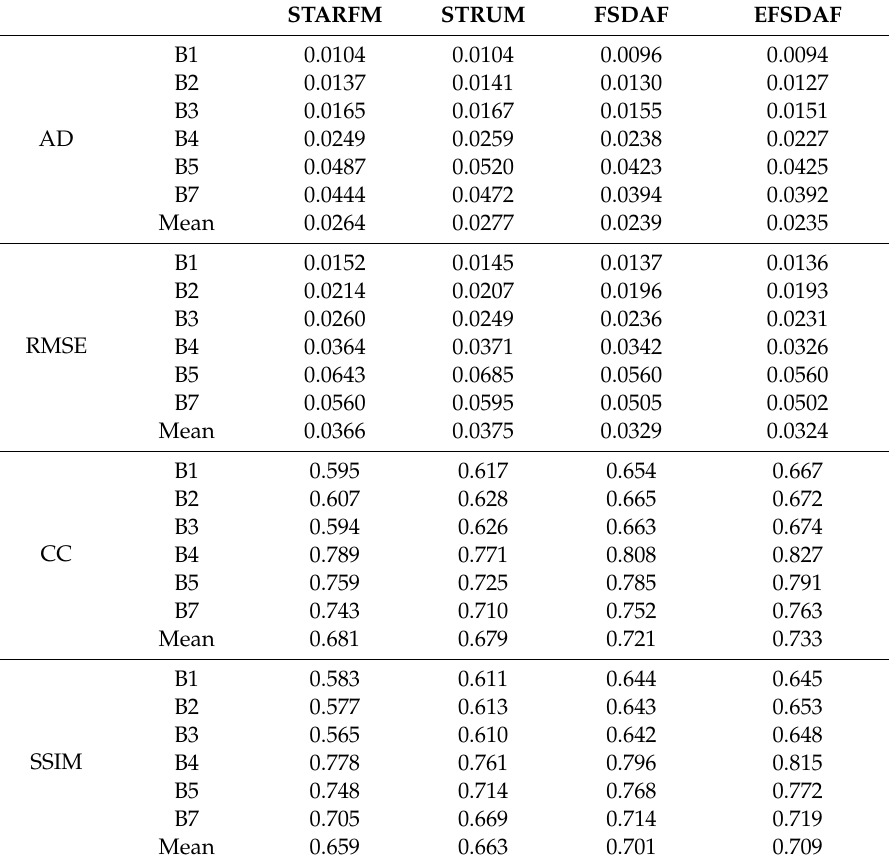
Table 2. Quantitative assessment of the Landsat-like images by STARFM, STRUM, FSDAF, and EFSDAF in dataset